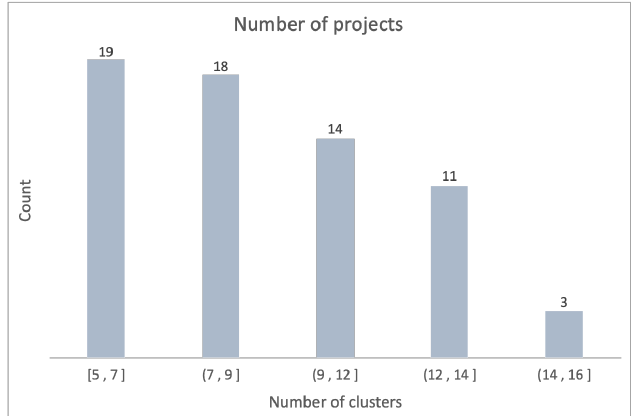
Figure 7. Number of clusters distribution of studied groups of projects (i.e., ALISW, LHCb, CMS-RW, and ROOT).